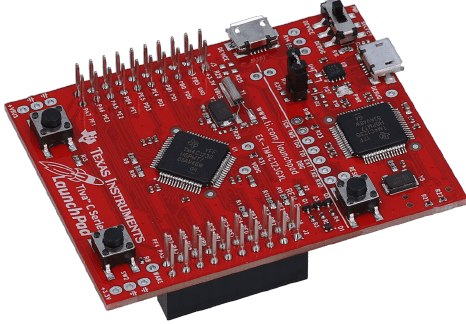
Figure 7. Texas Instruments TM4C123GXL Development